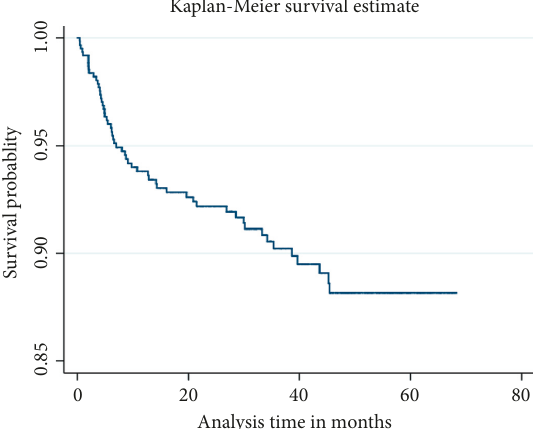
Figure 2: Kaplan-Meier survival estimate in adult HIV-infected patients under ART follow-up in health centers at Kirkos subcity Addis Ababa, Ethiopia,